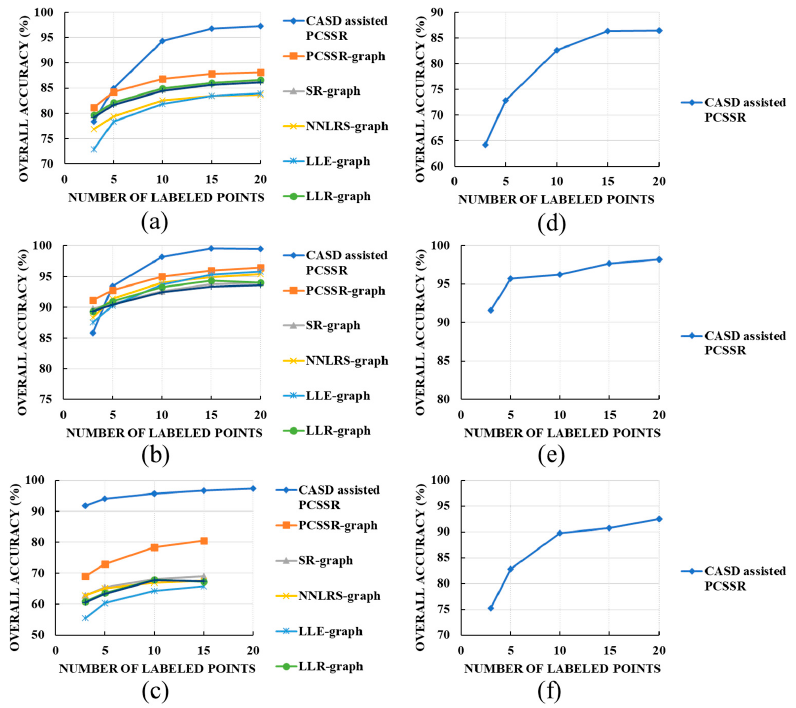
Figure 6. Overall accuracy with different number of labeled samples on all datasets. ( a ) KSC data with 13 classes ( λ 1 = 1 × 10 − 4 , λ 2 = 2 × 10 − 5 ). ( b ) BOT data with 9 classes ( λ 1 = 1 × 10 − 4 , λ 2 = 2 × 10 − 6 ). ( c ) Truncated IND PINE data with 16 classes ( λ 1 = 1 × 10 − 4 , λ 2 = 2 × 10 − 5 ). ( d ) IND PINE data with 16 classes ( λ 1 = 1 × 10 − 4 , λ 2 = 4 × 10 − 5 ). ( e ) SAL data with 16 classes ( λ 1 = 1 × 10 − 4 , λ 2 = 6 × 10 − 6 ). ( f ) Pavia University (PAV) data with 9 classes ( λ 1 = 1 × 10 − 4 , λ 2 = 4 × 10 − 6 ). Appl. Sci. 2020 , 10 , x FOR PEER REVIEW